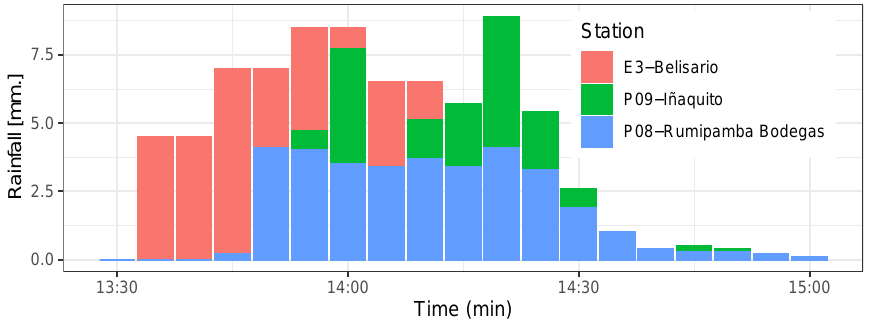
Figure 12. Hyetograms with 5-min record frequency of stations E3 Belisario, P08